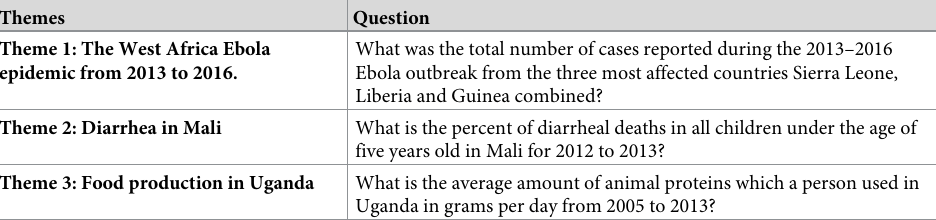
Table 3. Sample calibration questions presented to experts in the three African